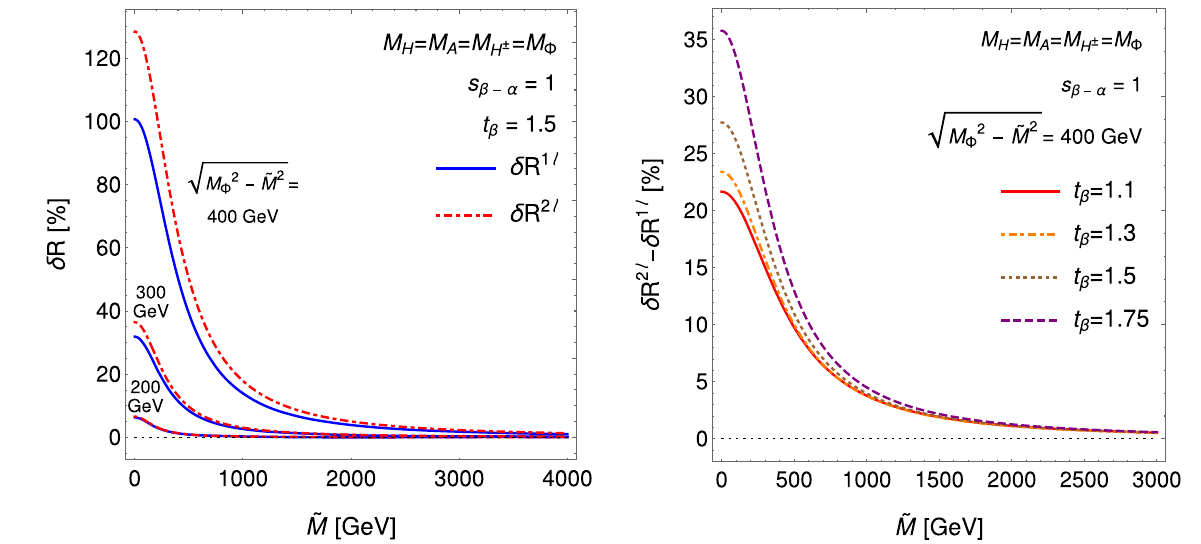
scalars. ( Right side ): Behaviour of the two-loop BSM contributions to ˆ λ δ R 2 (cid:26) − δ R 1 (cid:26) , as a function of ˜ M hhh in the 2HDM, shown here with and for several values of tan β , up to the higher value allowed under the criterion of tree-level perturbative unitarity. For this figure, the masses of the additional BSM scalar are once again taken to be degenerate, and M 2 Φ − ˜ M 2 = ( 400 GeV )